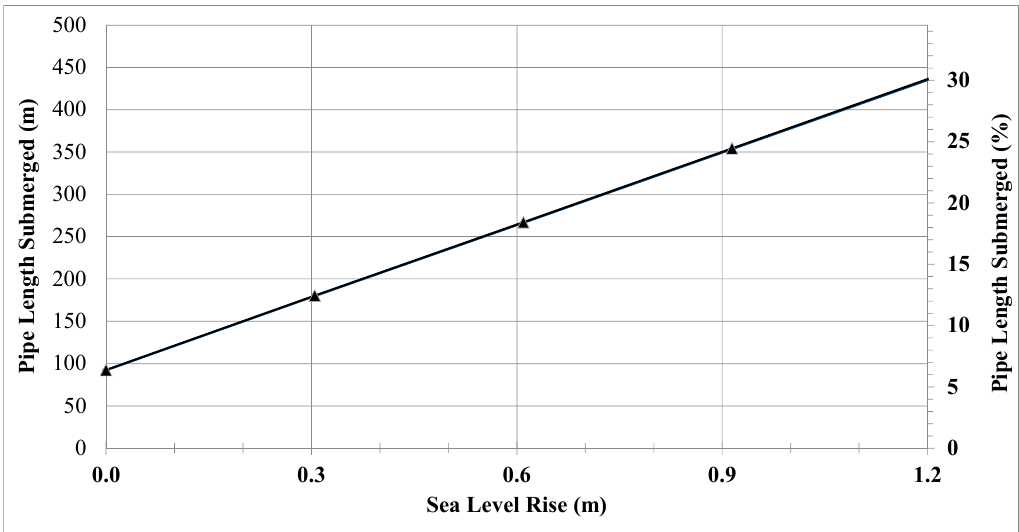
Figure 2. Length of sewer line submerged in study area as a function of SLR.